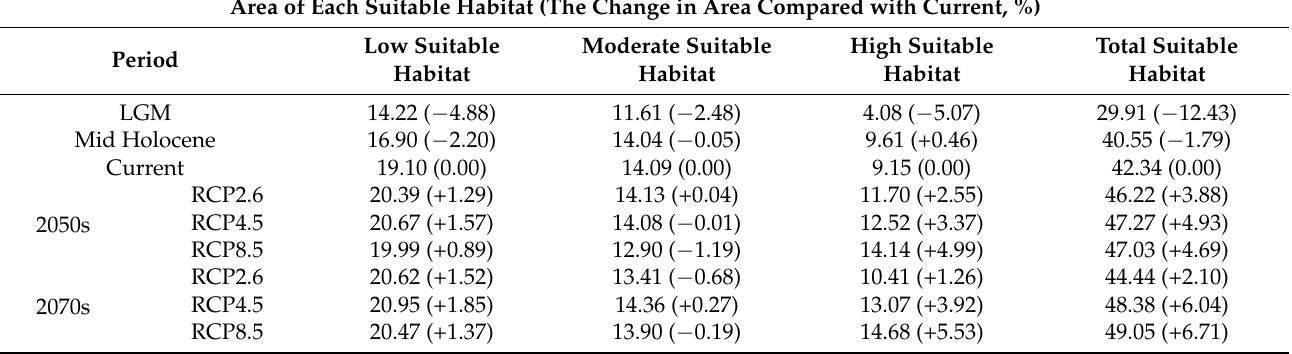
Table 5. The percentage change in each suitable area of Morchella in different